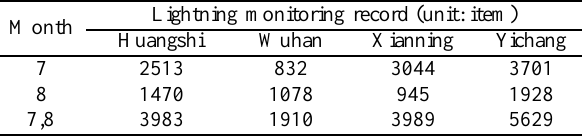
Table 8. Lightning monitoring data of Huangshi, Wuhan, Xianning, Yichang (2) Multi-source data The influence of terrain, meteorology, and vegetation was considered. The multi-source fusion (see Table 9) for lightning data can be obtained for the association rule mining based on the terrain data of Hubei Province (elevation, slope, and aspect), the meteorological data (precipitation, temperature, barometric pressure, relative humidity, etc.) and the vegetation coverage data. Among them, the reference of vegetation is shown in Table 10, and the classifications of aspect and direction of maximum wind speed are determined according to the angle (see Figure 3).